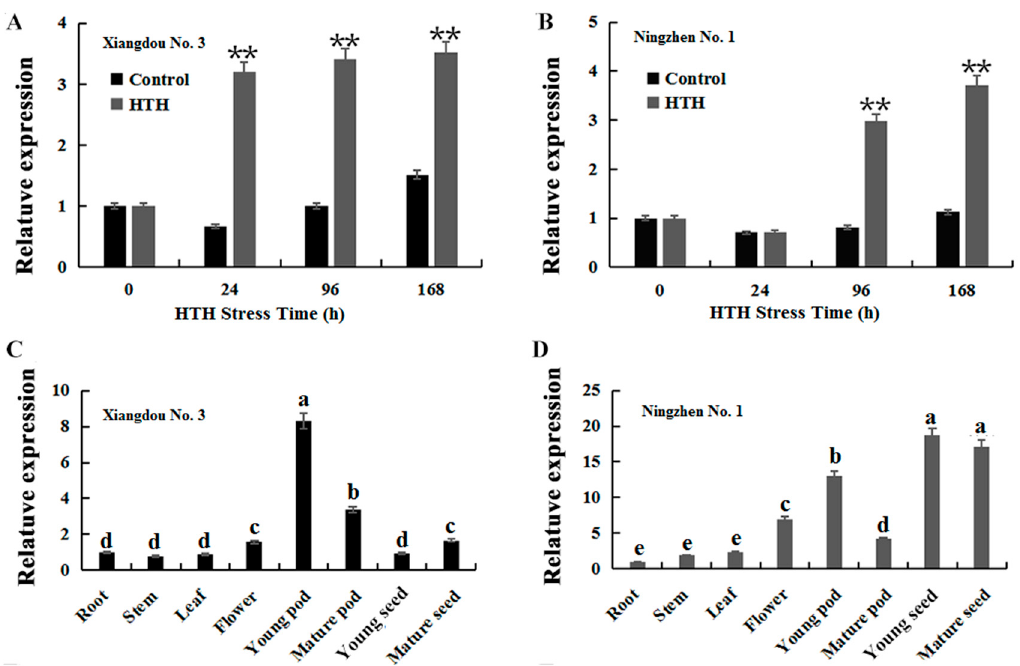
Figure 2. Expression patterns of GmATX1 in soybean. ( A , B ) Expression patterns of GmATX1 in the developing seeds of soybean cvs. Xiangdou No. 3 and Ningzhen No. 1 at the R7 stage, treated with the HTH stress for 0, 24, 96, and 168 h. ( C , D ) Expression of GmATX1 in various tissues in soybean cvs. Xiangdou No. 3 and Ningzhen No. 1 under normal growth and development conditions. Young seed, developing seed at the R5 stage (beginning of bulge); mature seed, seed at the R7 stage (maturity). ** Indicates significant differences between the control and the treatment at p < 0.01; different letters within a cultivar indicate significant differences at p < 0.05. Values are mean ± SD from three biological replicates.